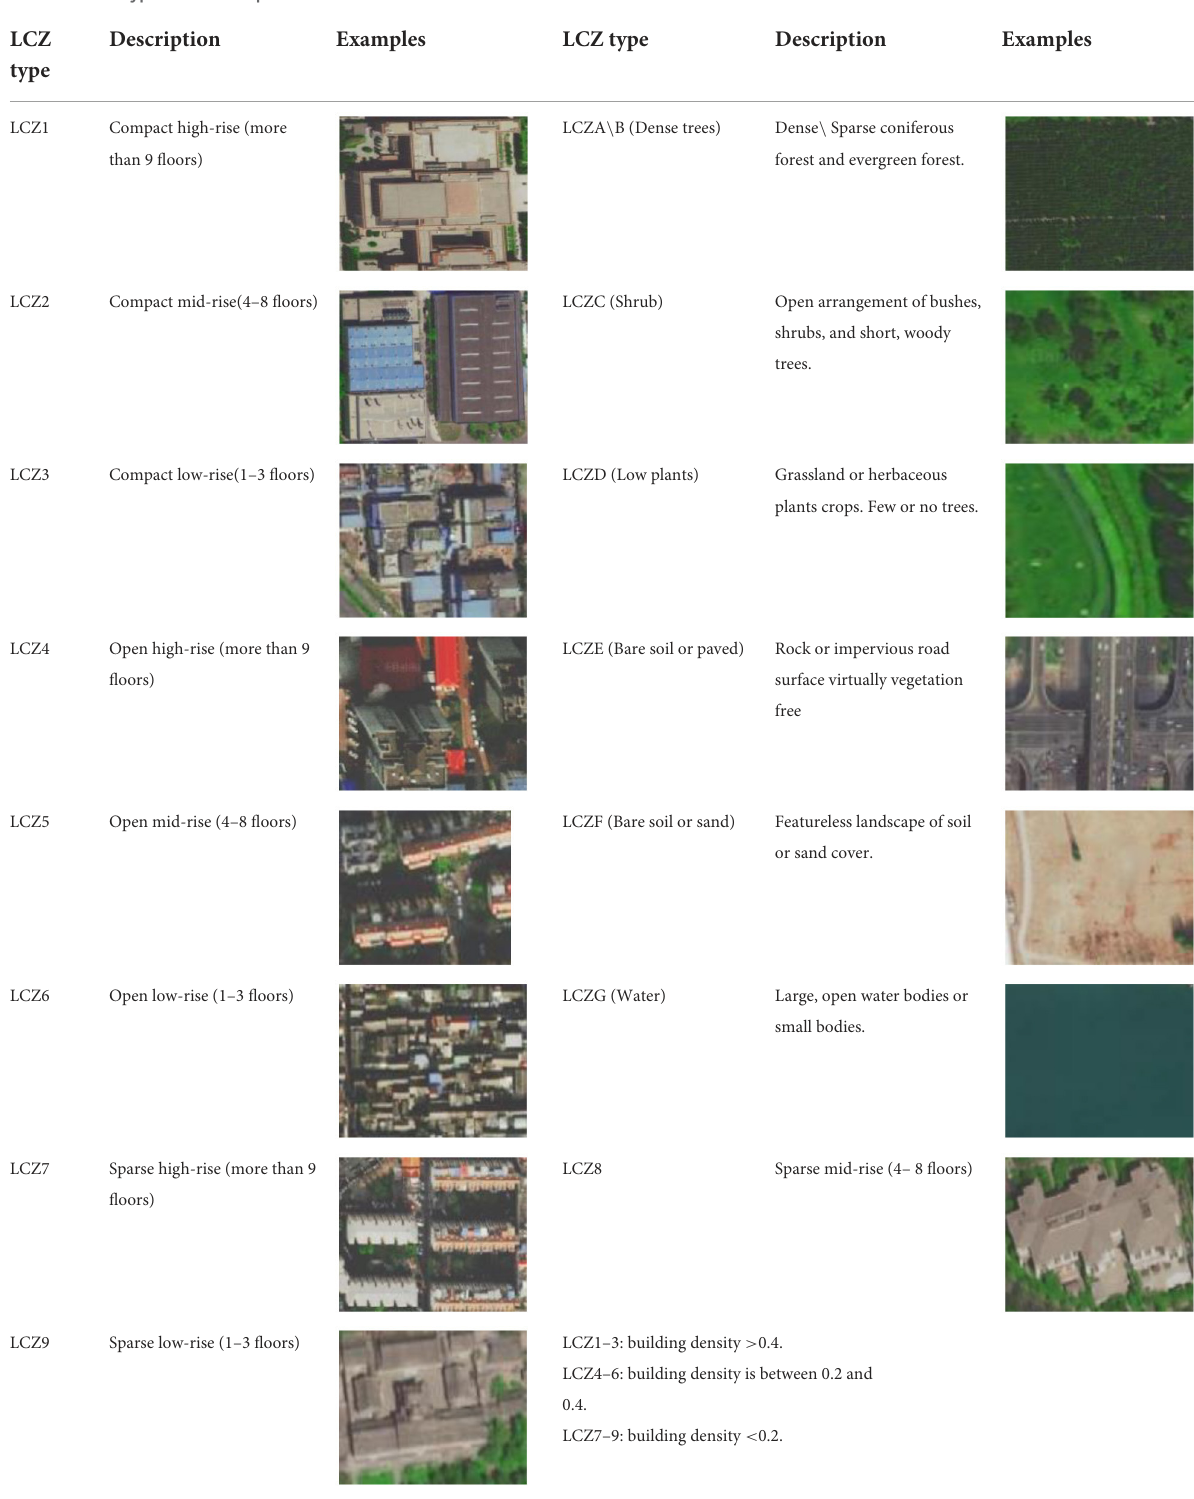
TABLE 2 LCZ types and